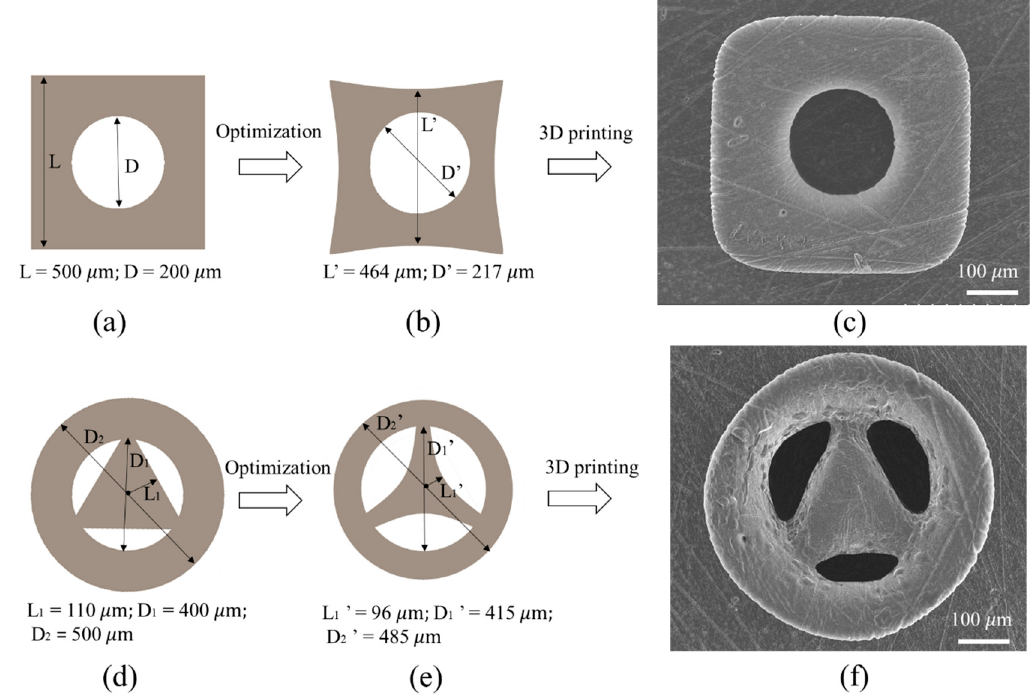
Figure 11. The 3D printing experiments. ( a , d ) Designed structures, ( b , e ) optimized structures, ( c , f ) 3D printed models.